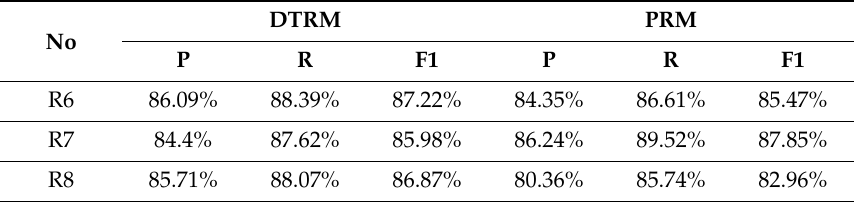
Table 5. Comparison results of DTRM and PRM in Area